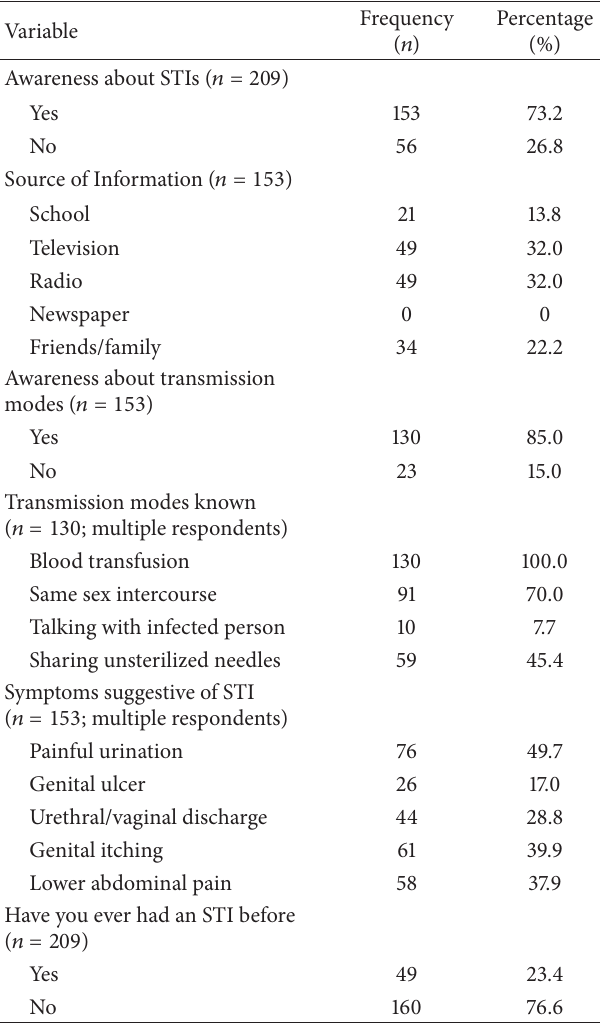
Table 2: Knowledge about